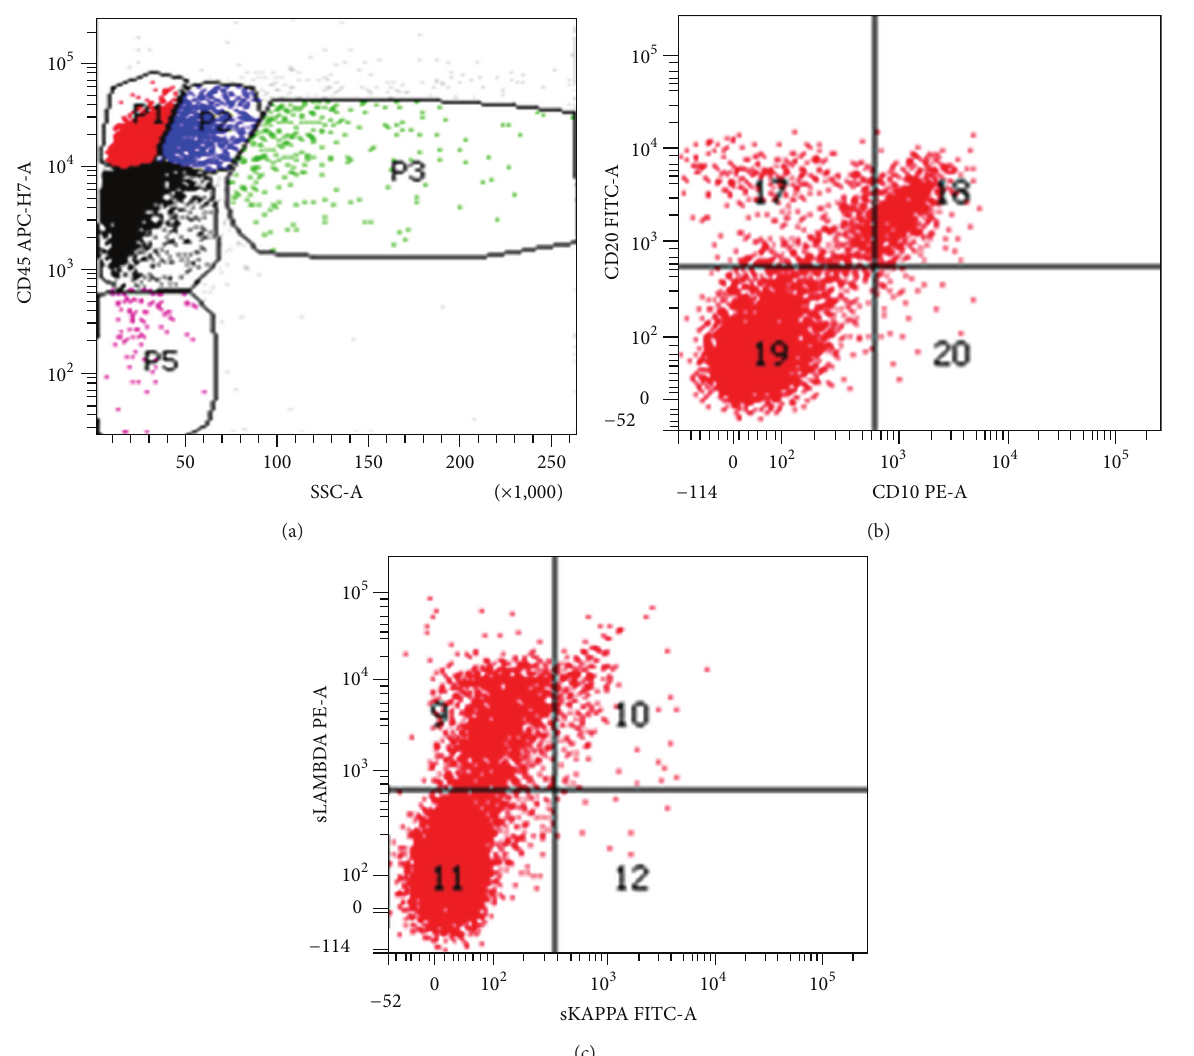
Figure 3: (a) Flow cytometry of the ungated specimen of the abdominal mass showing a Cd45 bright population, compatible with a lymphoproliferative process (rather than a carcinoma, melanoma, etc.), (b) gating only the CD45 bright/low side scatter population shows a predominant CD20+/CD10+ population, consistent with a B-cell population of germinal center origin, and (c) light chain expression shows lambda light chain restriction, diagnostic of a B-cell